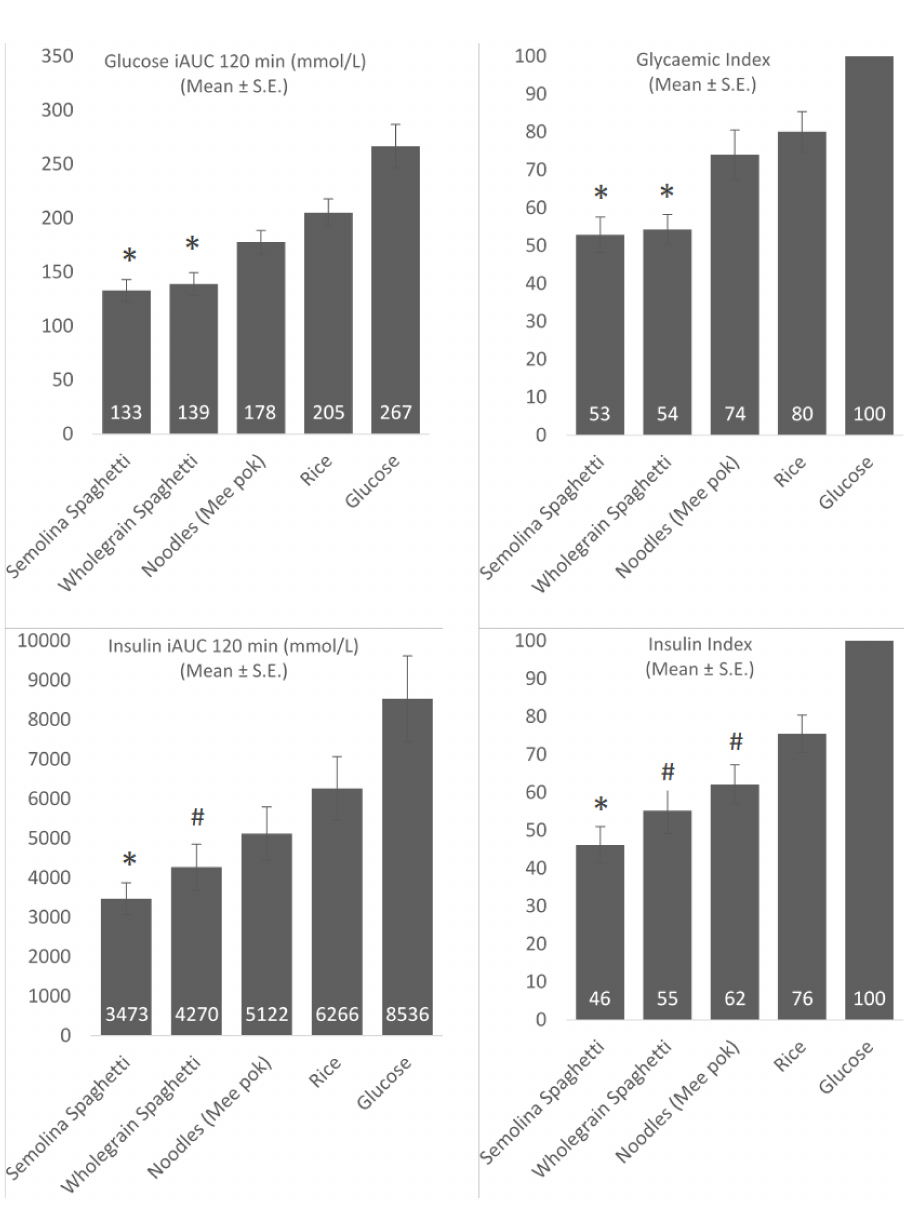
Figure 3. Glycaemic and insulinaemic response as incremental area under the curve (iAUC) (mmol/L) and indexed versus the glucose treatment. Mean ± standard error * ( p < 0.05) different from mee pok and rice, # ( p < 0.05) different from